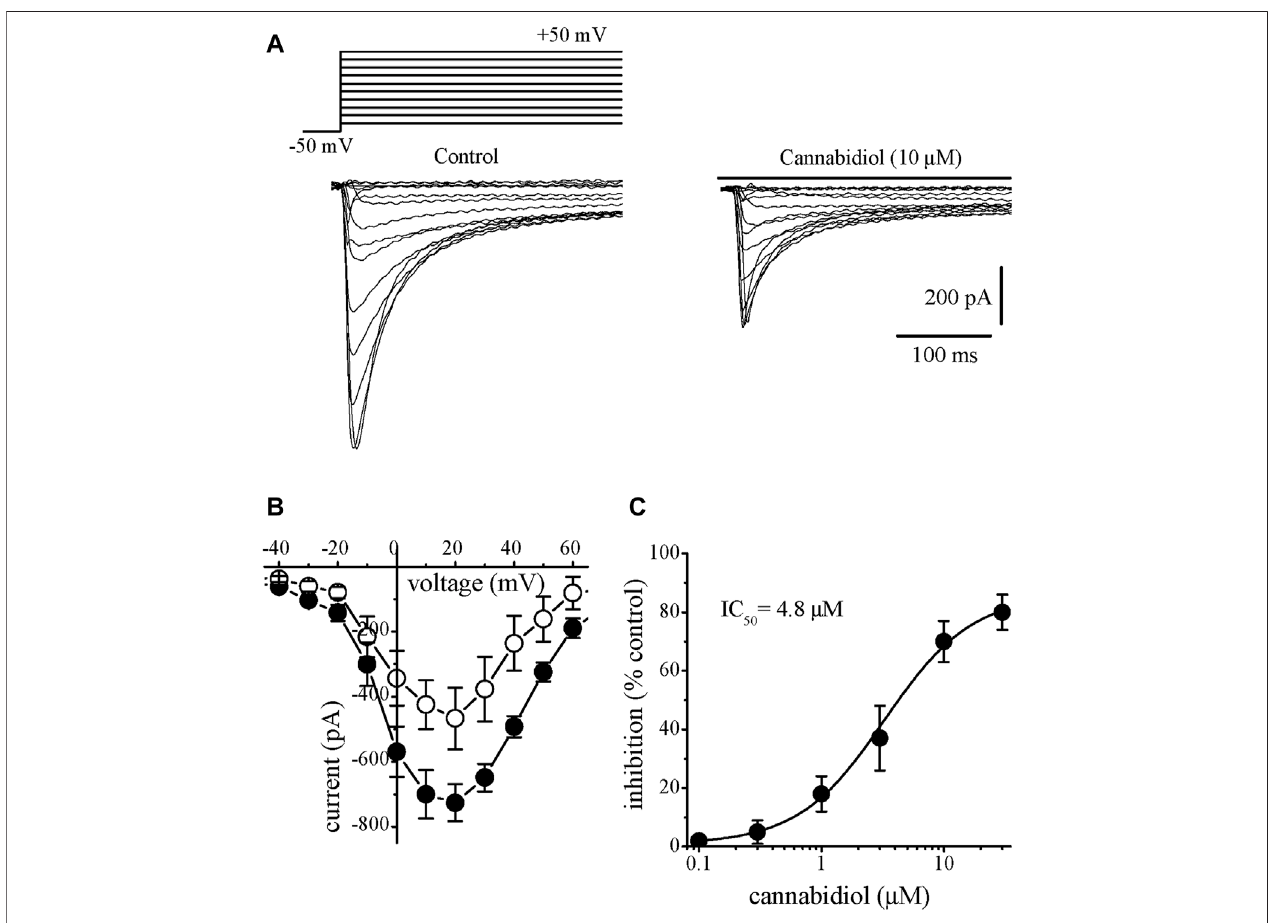
FIGURE 2 | Cannabidiol inhibits the I L-Ca in rabbit ventricular myocytes (A) Original current traces elicited by voltages in the range of − 50 mV to +50 mV in control conditions (on the left) and after 10 min exposure to 10 μ M CBD (on the right). The pulse protocol to evoke I L-Ca is presented in the inset (B) Current-voltage relations of I L-Ca intheabsenceandpresenceof10 μ MCBDarepresentedwith fi lledandopencircles,respectively(n (cid:1) 6) (C) Concentration-inhibitioncurveforCBDsuppressionof I L-Ca (n (cid:1) 5 –